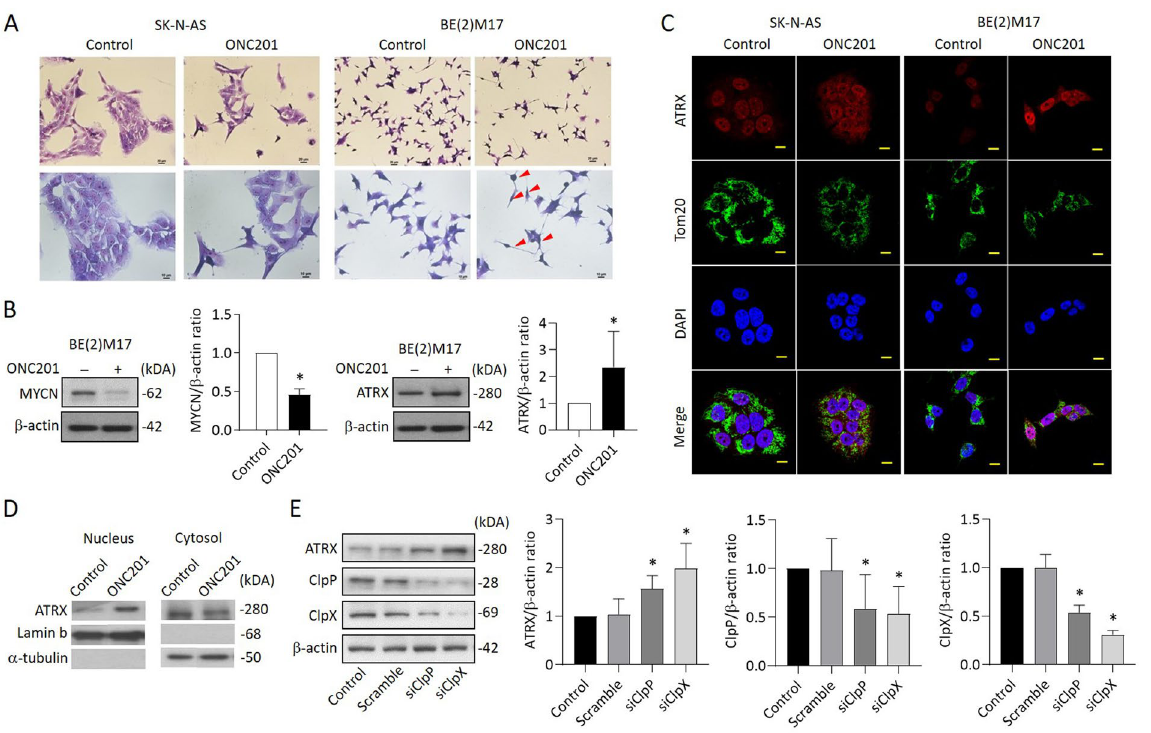
Figure 5. Effects of ONC201 on neurite outgrowth and the express profiles of ATRX in NB cells: ( A ) Representative of Giemsa staining in ONC201-treated SK-N-AS and BE(2)M17 cells. Scale bar 20 µ m ( upper panel ) and 10 µ m ( lower panel ), respectively. Red arrow indicates the neurite extension. ( B ) Western blot analysis of MYCN and ATRX protein in ONC201-treated BE(2)M17 cells. The relative protein ratio was normalized with β -actin using Image Pro-plus analysis software. ( C ) Representative images demonstrating ATRX enhancement (red) in the nucleus of SK-N-AS and BE(2)M17 cells when exposed to ONC201 (5 µ M) for 48 h. The mitochondria were labeled with anti-TOM20 antibody (green). The nuclei were labeled with DAPI (blue). Scale bar 10 µ m. ( D ) Western blot analysis of ATRX protein in nuclear and cytosolic fractions in BE(2)M17 cells. The relative ATRX ratio was normalized with lamin b and alpha-tubulin, respectively, and expressed as mean ± SD. ( E ) Analysis of ATRX expression in siClpP- and siClpX-treated SK-N-AS cells by Western blot. The relative protein ratio was normalized with β -actin, and is expressed as mean ± SD. All data were obtained from four to six independent experiments. * p <